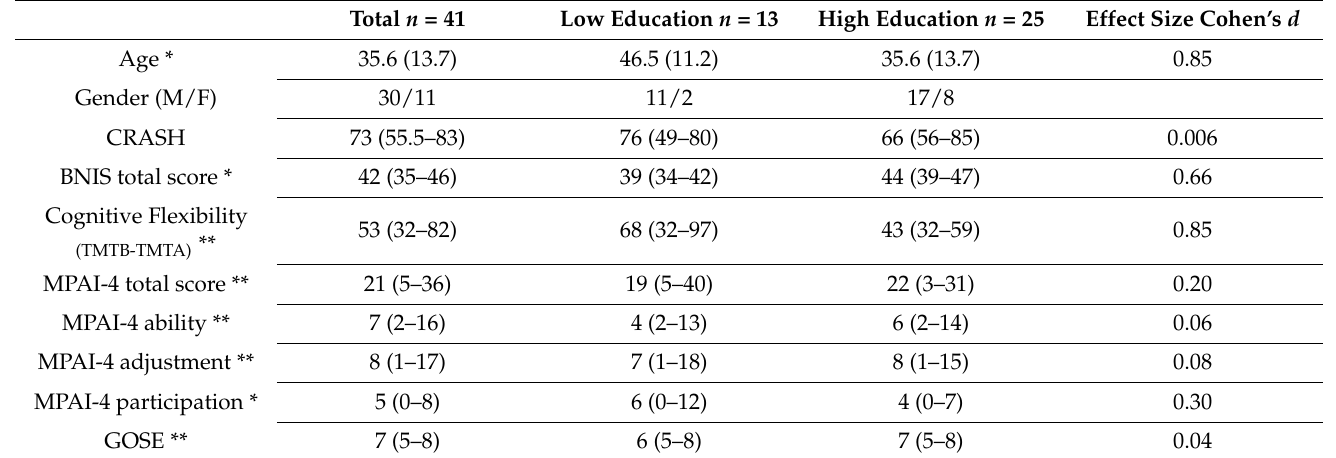
Table 1. Descriptive statistics for all participants, separated by educational level.